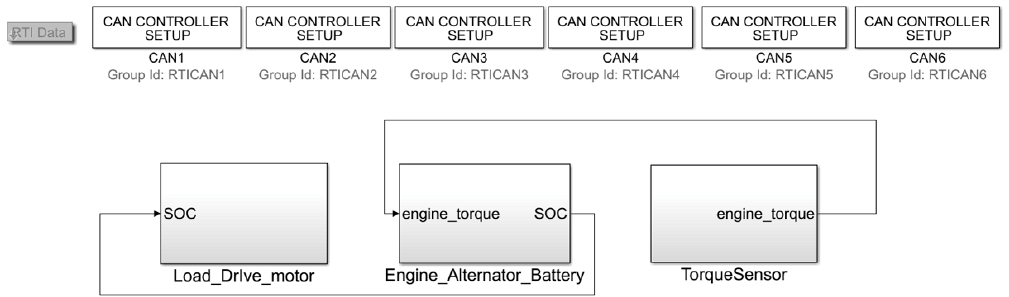
Figure 6. The control model framework of the series hybrid powertrain used in electric tractors.